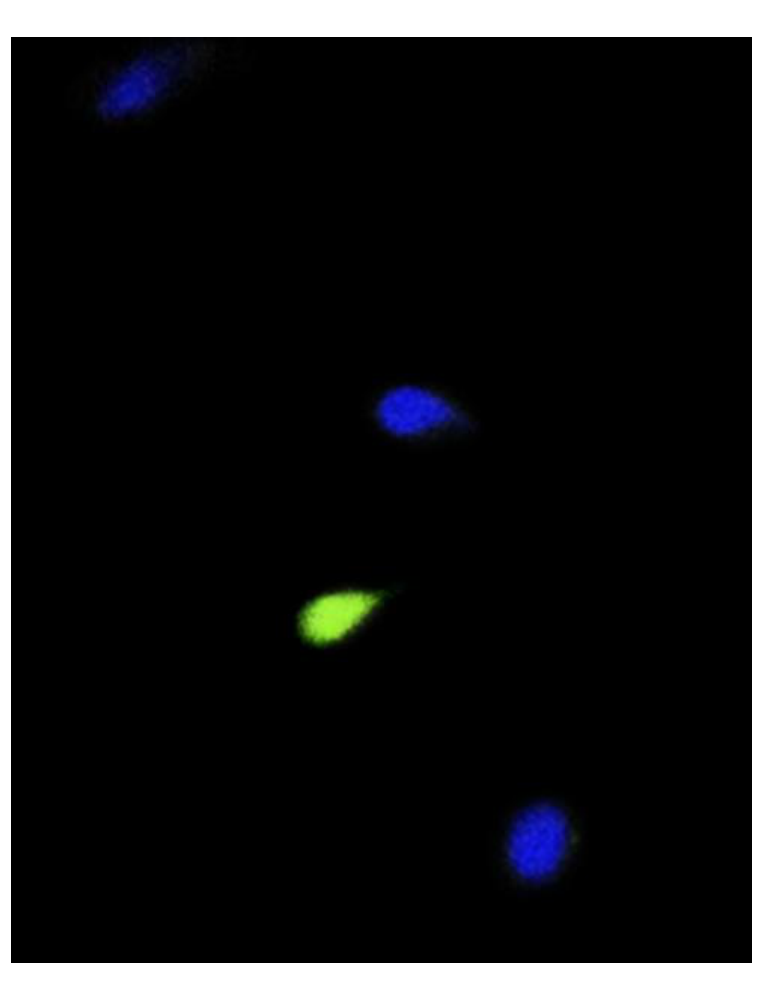
Figure 3. Intracellular ROS (green cell) in human sperm cell analyzed by fluorescent microscopy using DCFH 2 -DA probe.